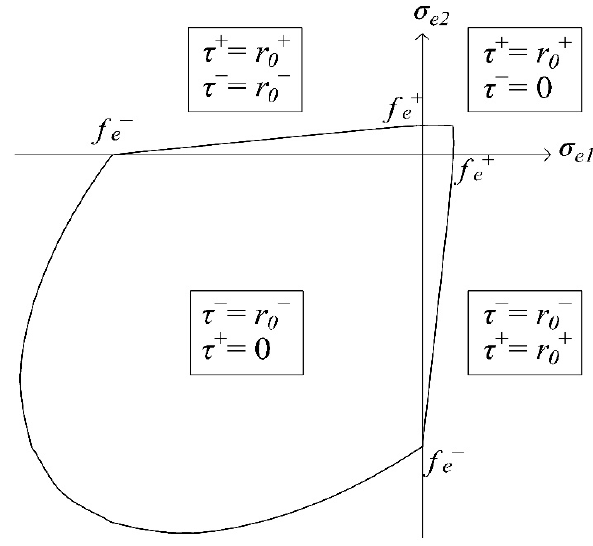
Figure 2. Damage surface in plane stress conditions, for α = 0.121 and β = 7.667.